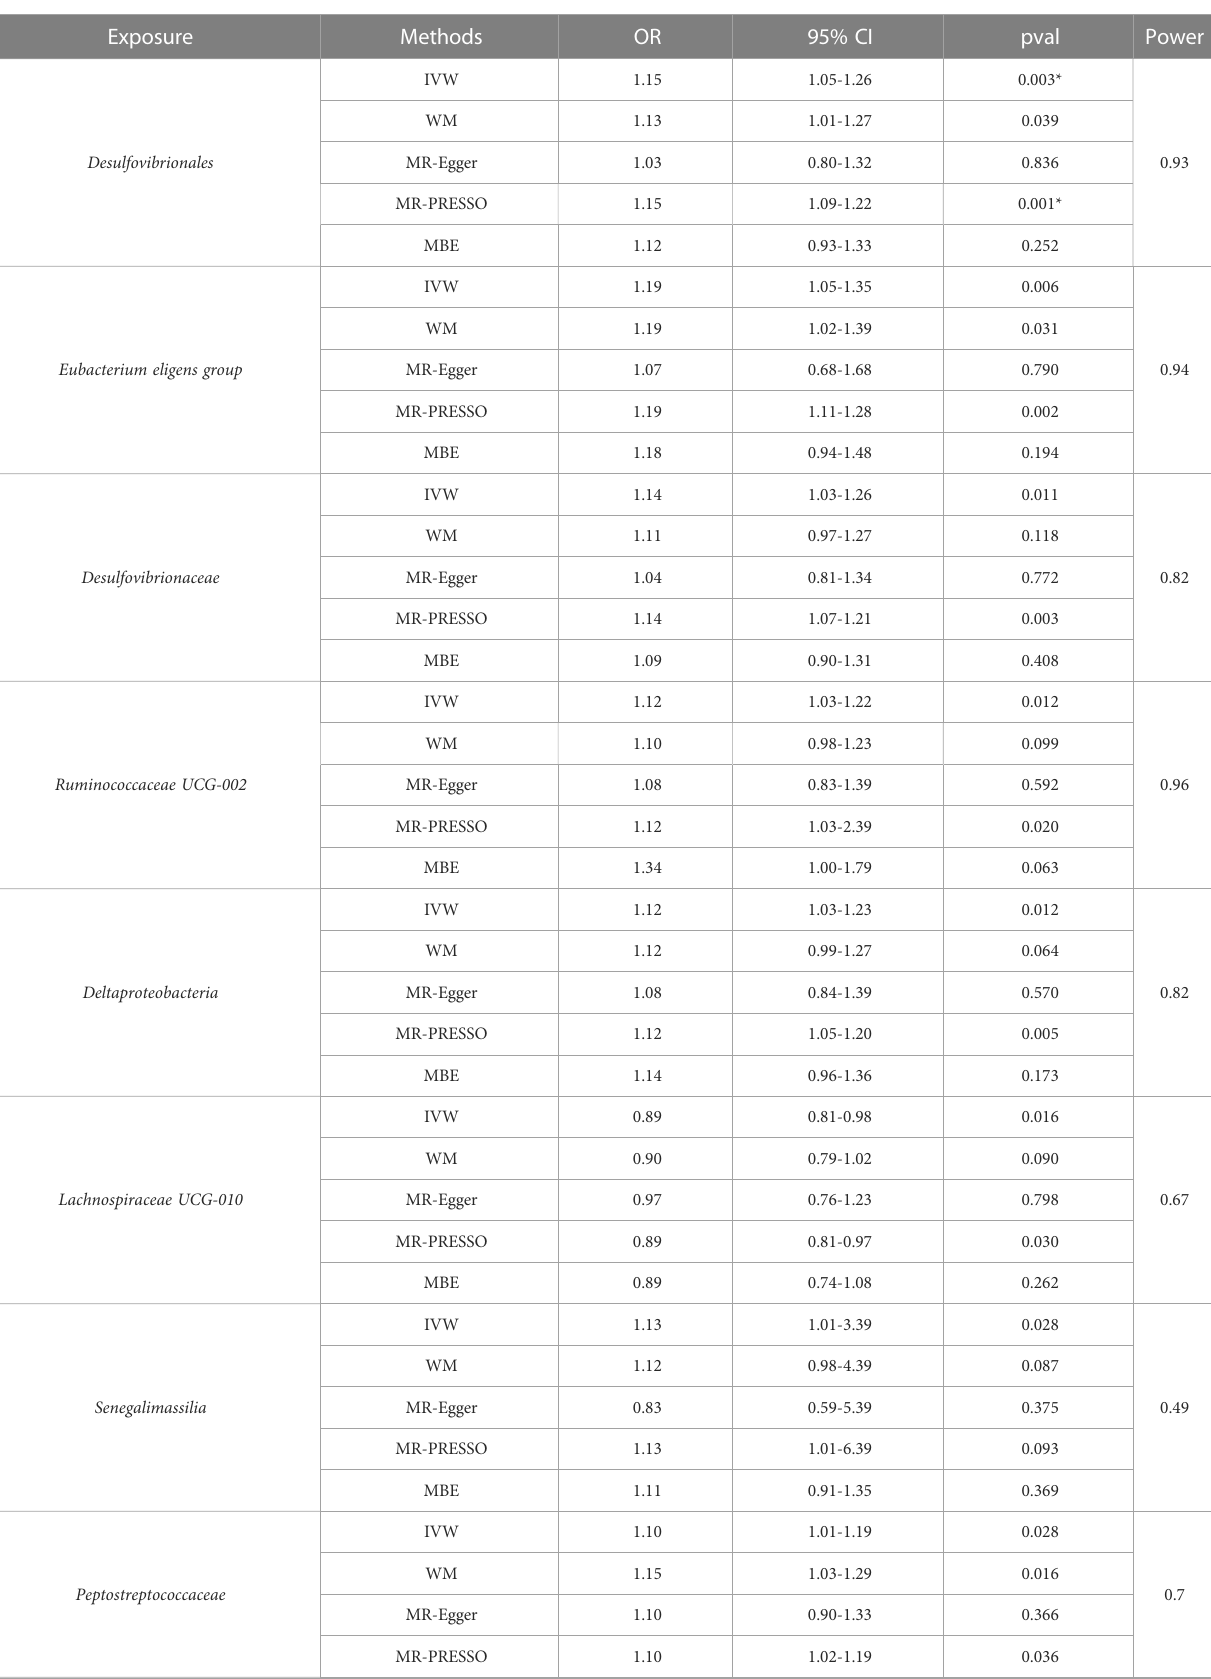
TABLE 1 Signi fi cant and nominal signi fi cant MR